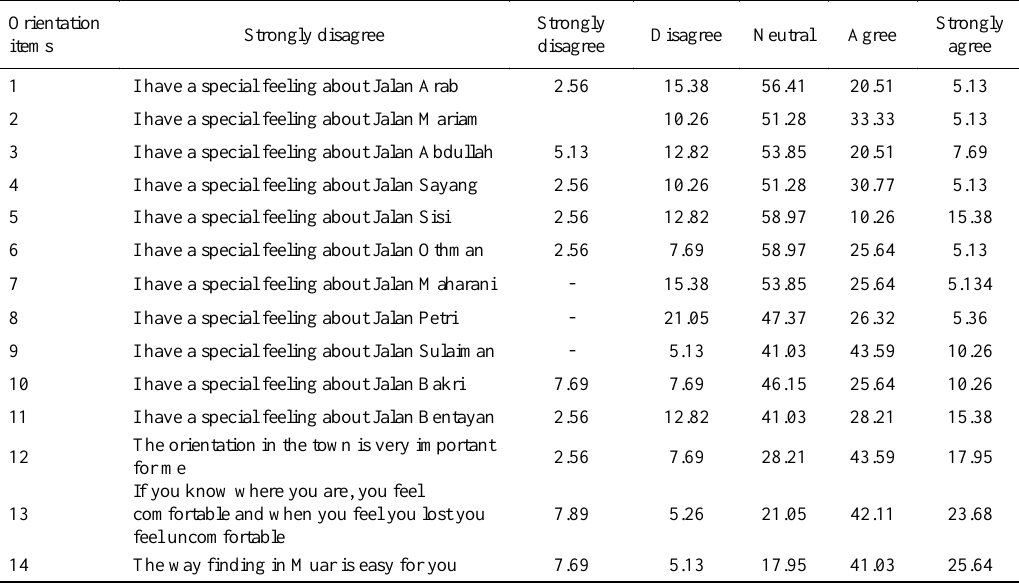
Table 1: Degree of orientation in Muar